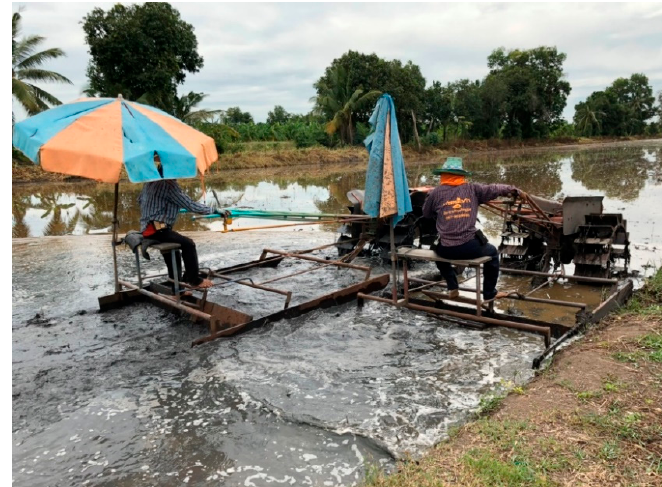
Figure 5. Land preparation.